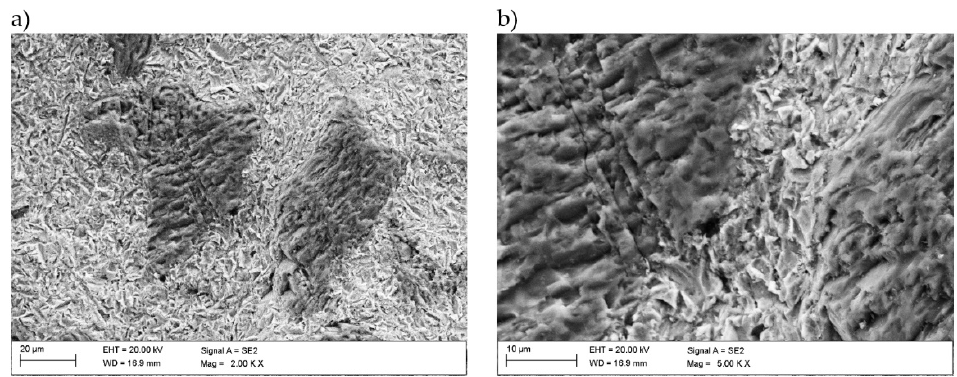
Figure 14. SEM micrographs of craters received after erosion test with impingement angle 30°, magnification ( a ) 2000x, ( b ) 5000x.